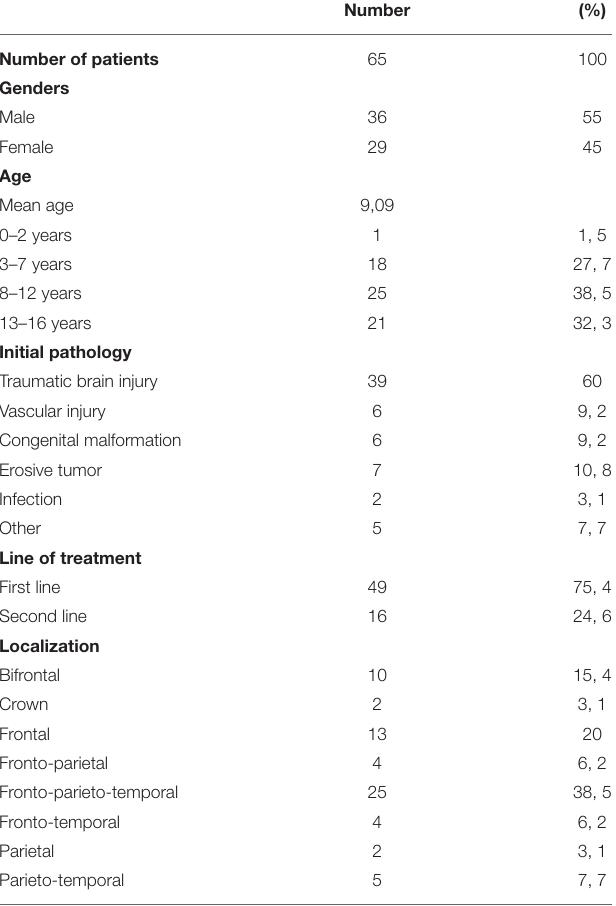
TABLE 3 | Demographic and epidemiological data.